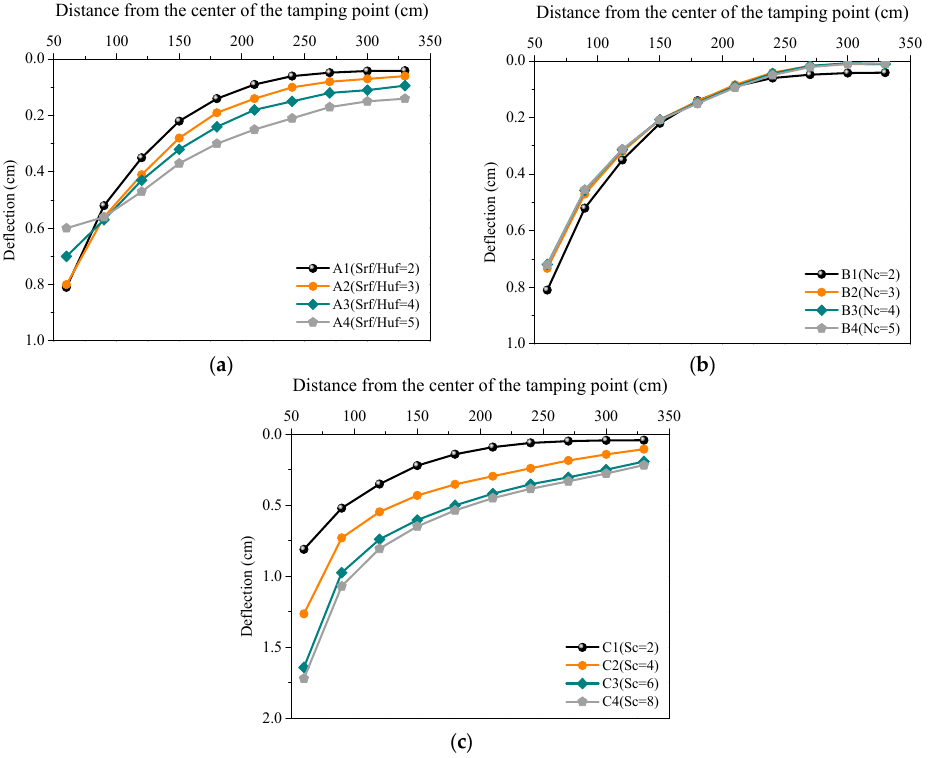
Figure 8. Deflection of reinforced geogrid under di ff erent reinforced factors: ( a ) embedded ratio; ( b ) number of reinforced layers; ( c ) interval of reinforced layers.